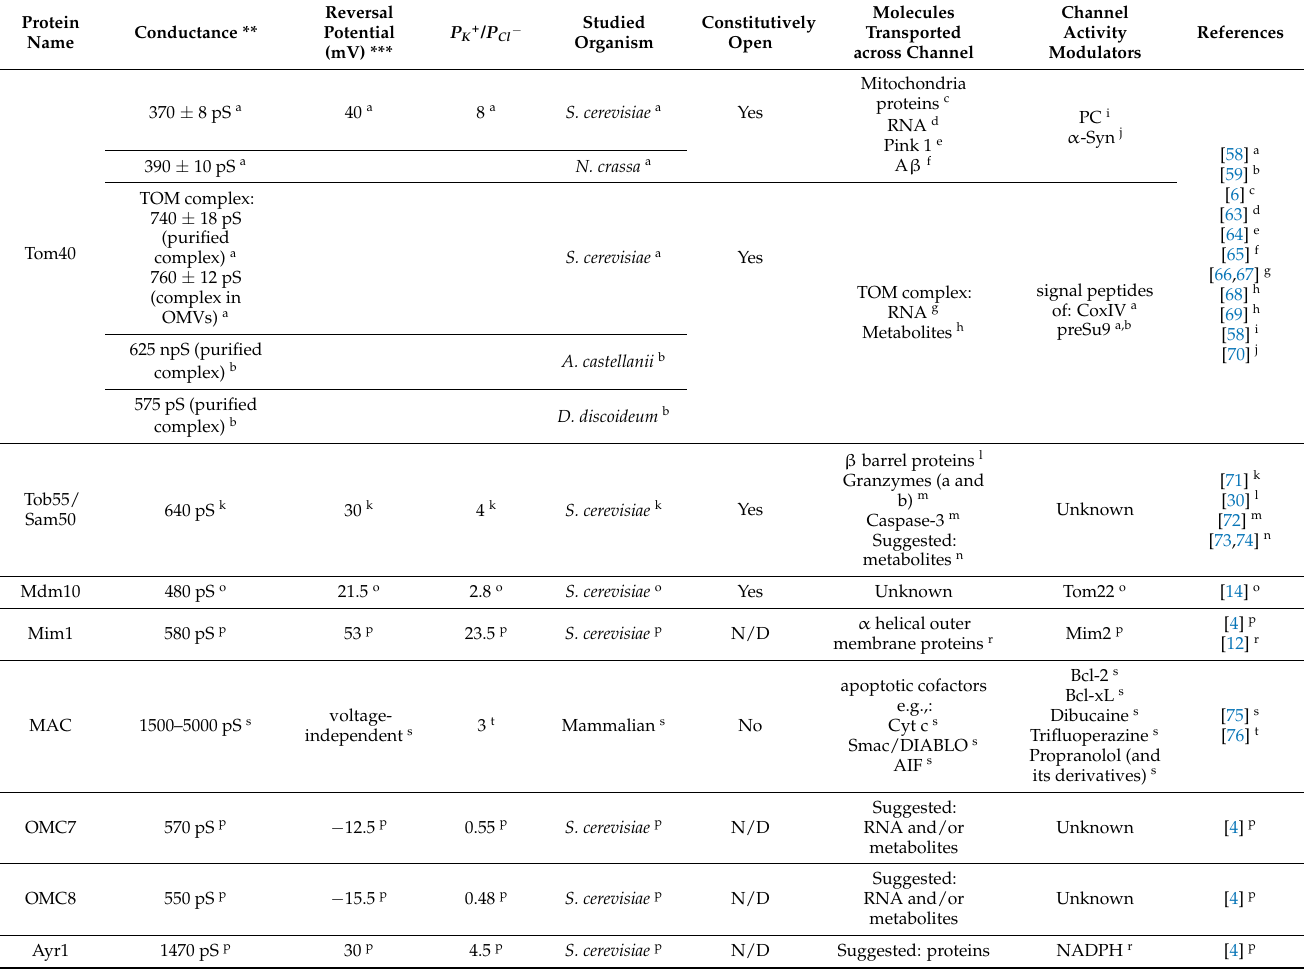
Table 1. Characteristics of the mitochondrial outer membrane channels based on reconstitution studies